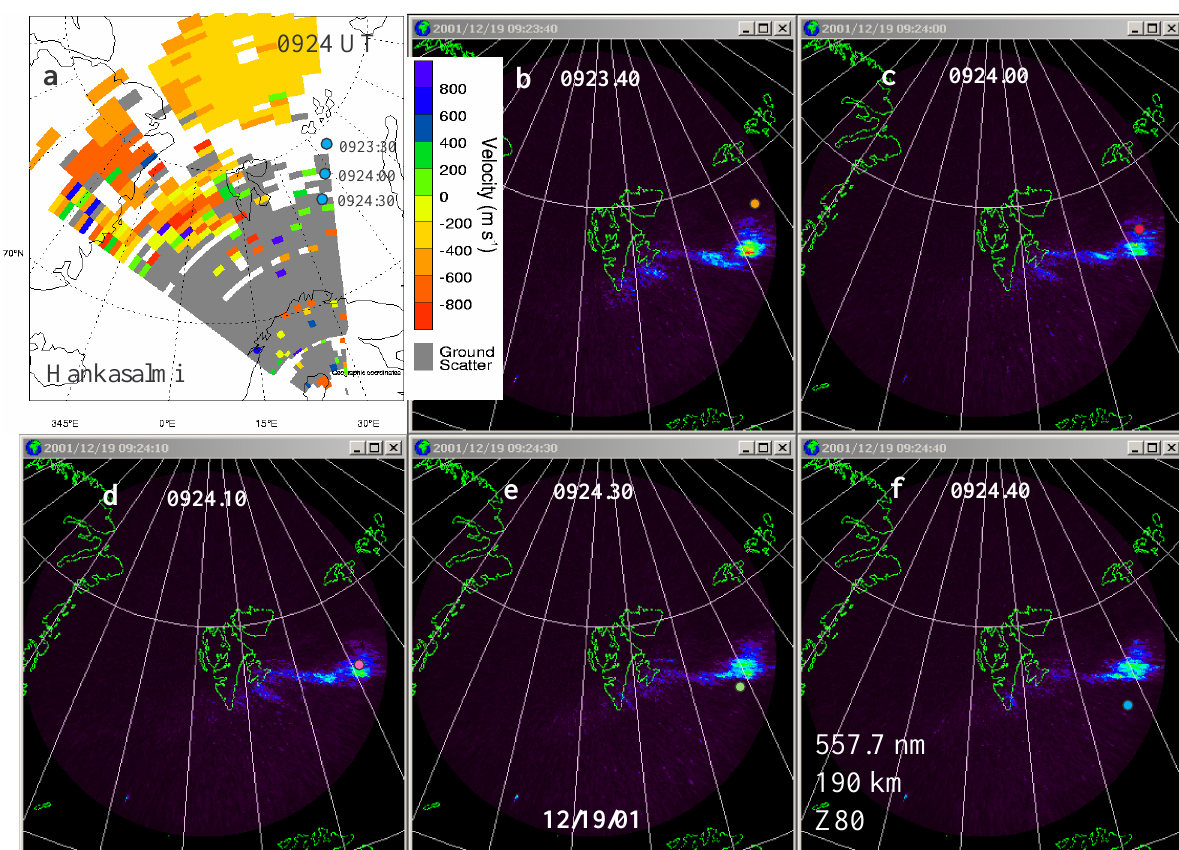
Figure 15 Fig. 15. ( b − f ) 557.7-nm all-sky images. The images have been extended to 80 ◦ zenith angle to cover the mapped positions of DMSP